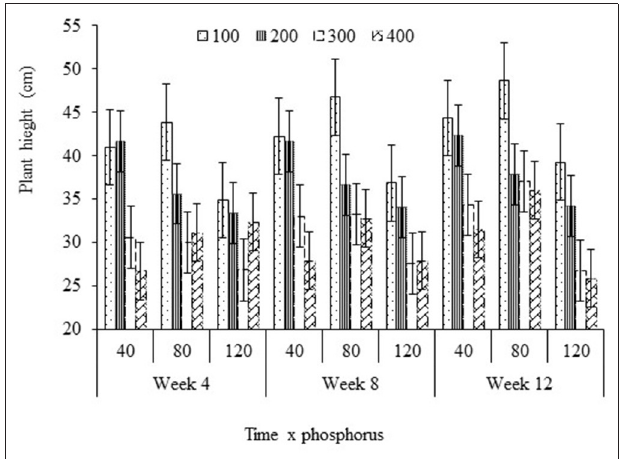
FIGURE 2 | Effect of phosphorus and nitrogen rates on plant height. Error bars indicate standard